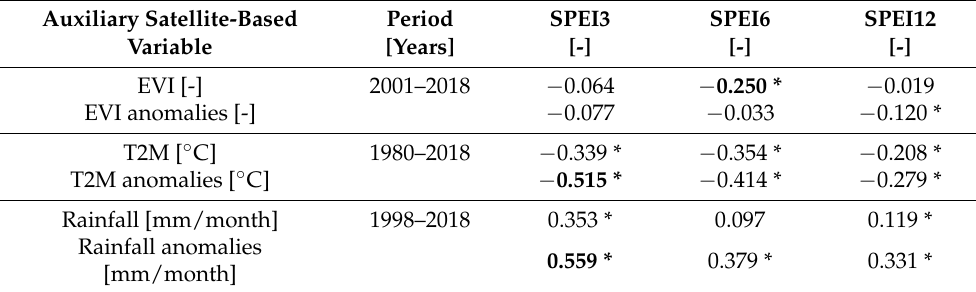
Table 3. Spearman rank correlation coefficients between the SPEI3, SPEI6, and SPEI12 and the EVI, T2M, and rainfall in the ARB during their common time periods 1 . Auxiliary Satellite-Based Period Variable [Years]